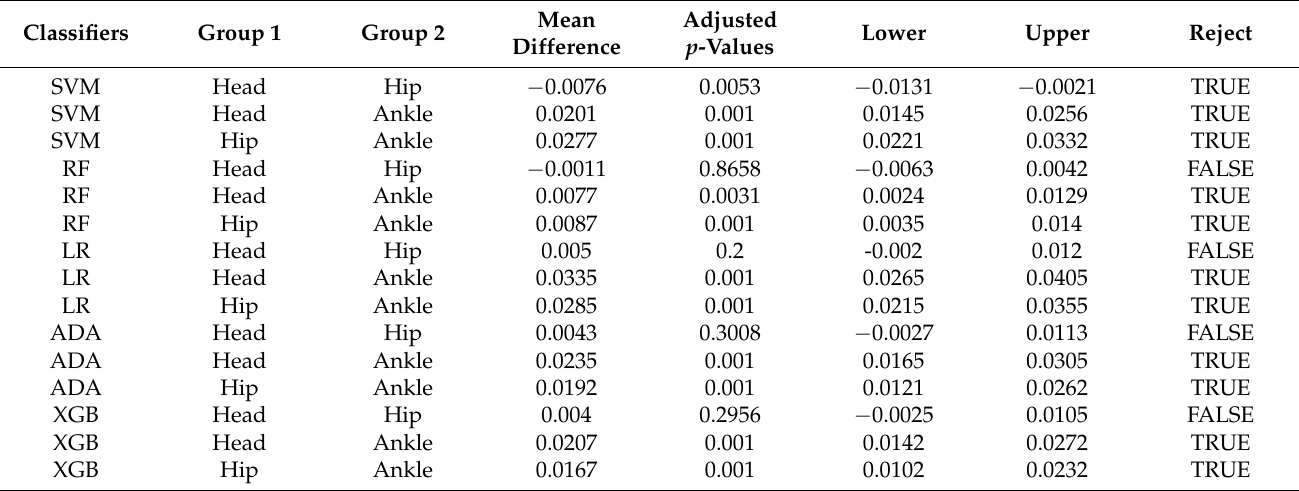
Table 4. Tukey’s pairwise comparison for location pairs across classifiers.